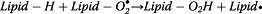
The proposal reaction of caffeic acid to scavenge DPPH· (step 1).